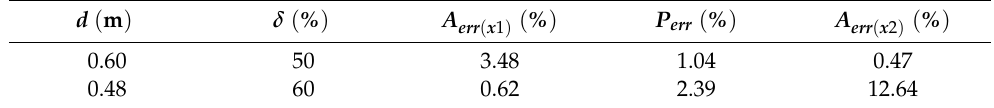
Table 5. Reconstruction errors of